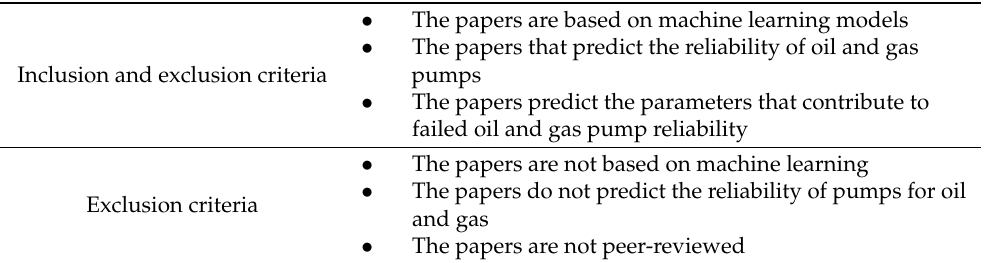
Table 5. Article filtering criteria based on machine